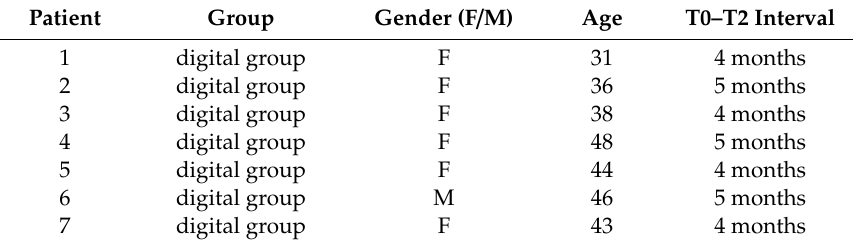
Table A1. Individual patient’s demographic data and treatment